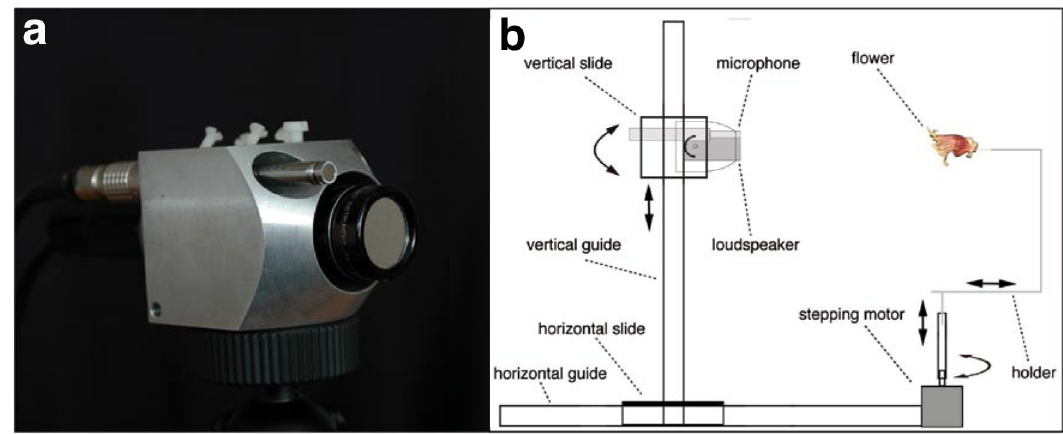
Fig 6. The setup used to measure ultrasonic echoes. (a) The biomimetic sonar head with the ¼ ” G.R.A.S. microphone and the custom build EMFI- transducer. ( b ) Schematic illustration of the measuring